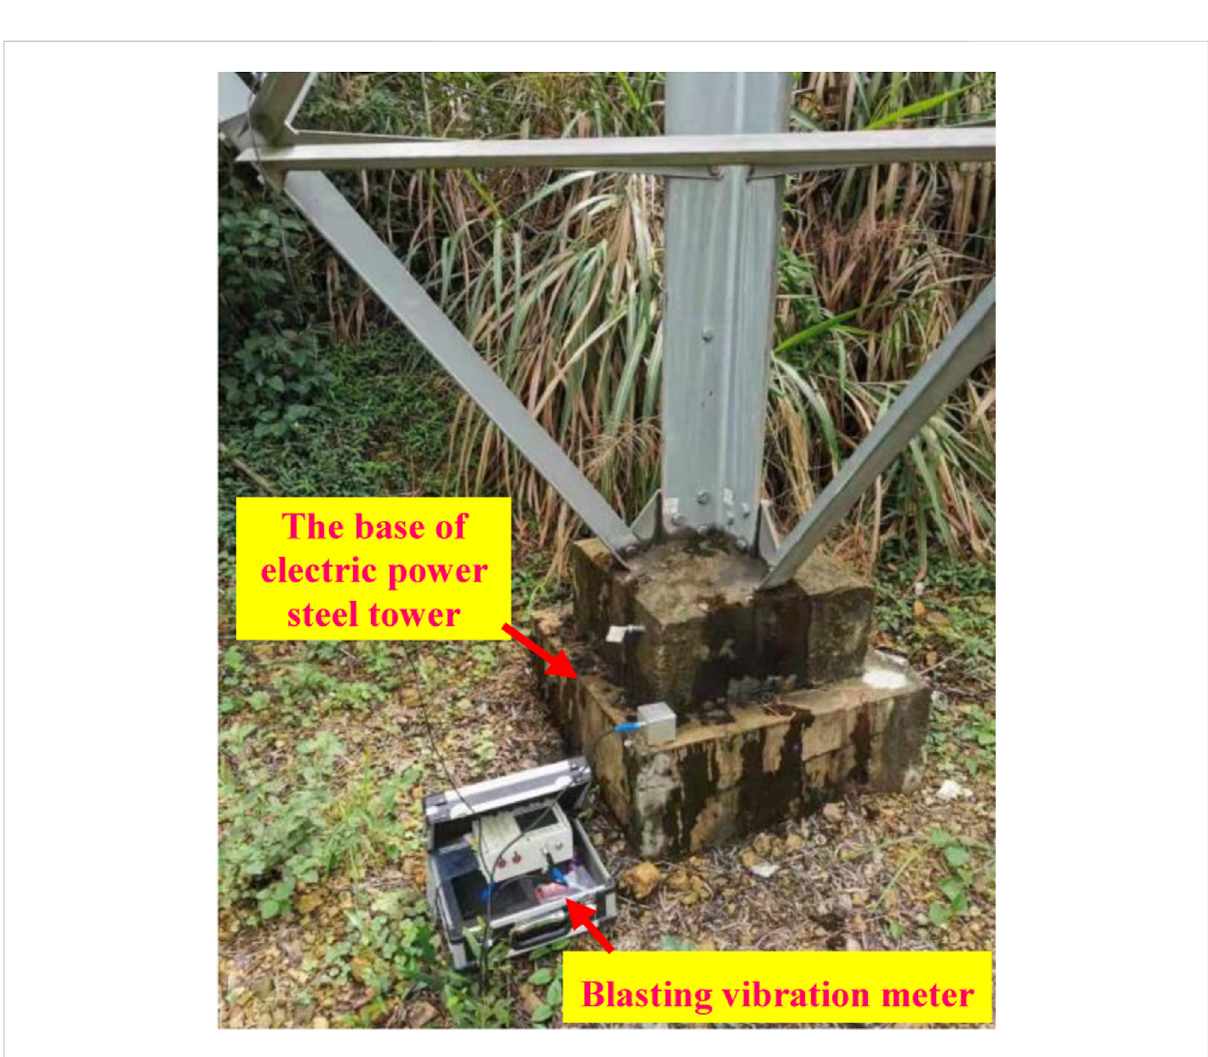
FIGURE 3 Electric power tower base and blasting vibration